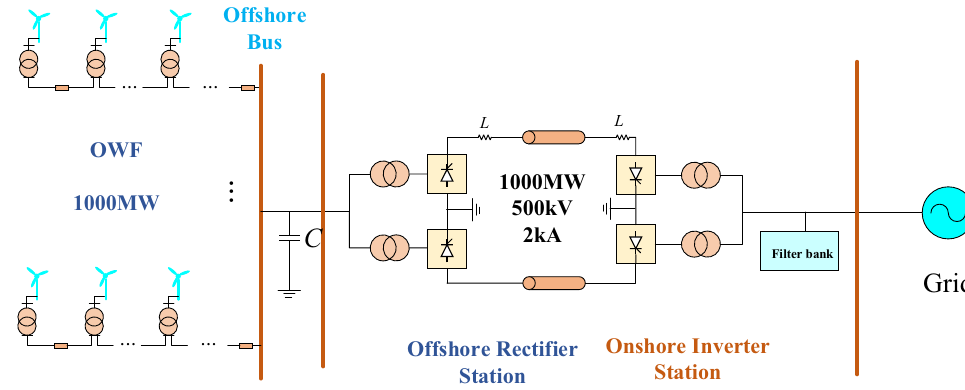
Fig. 7 OWF with LCC-HVDC link connection (HVDC Benchmark